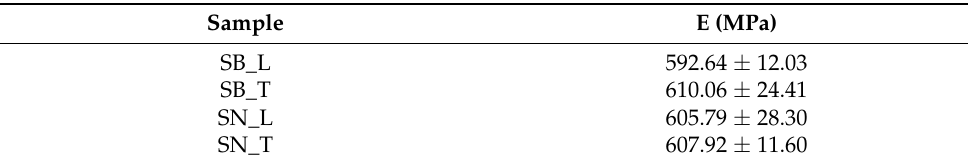
Table 4. Young’s modulus values for longitudinal (L) and transverse (T) PFA films after aging on white (SB) and black (SN) supports.